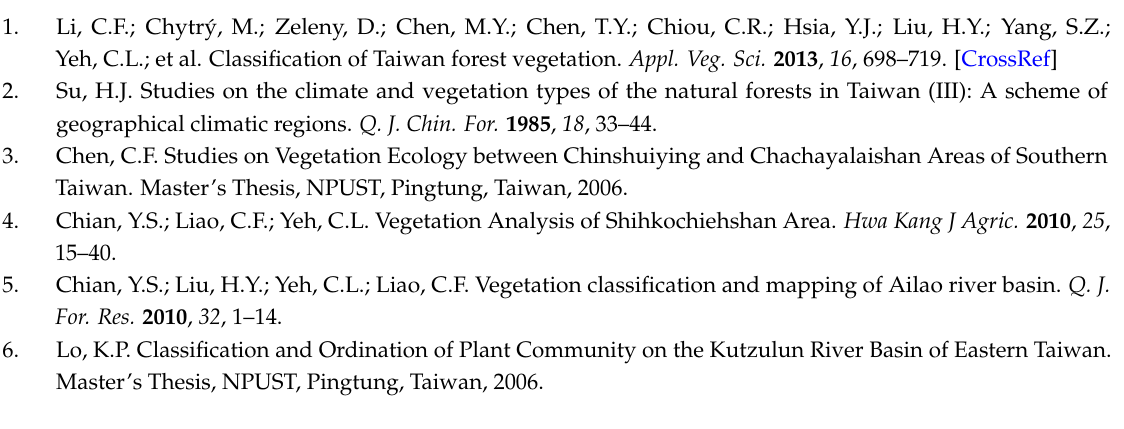
Table S1: Plant list in study area, Table S2: Synoptic table of